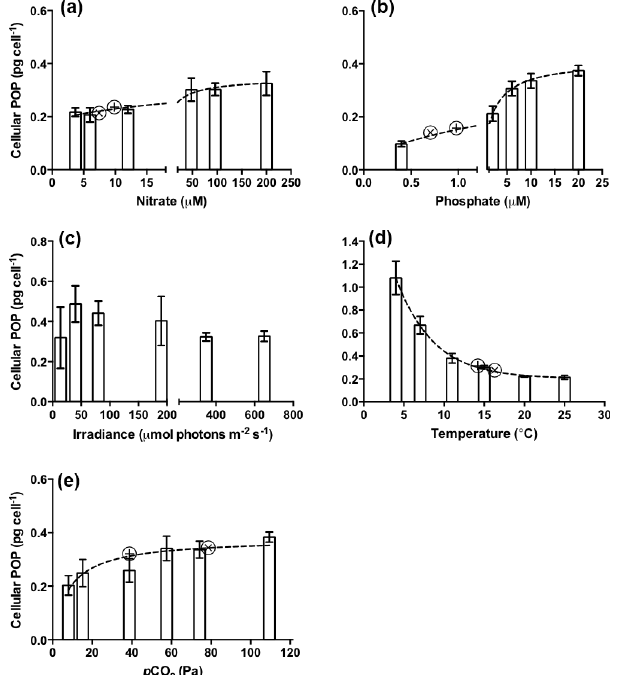
Figure 6. Changes in the ratio of Emiliania huxleyi cellular partic- ulate organic carbon content to chlorophyll a content (C:Chl a ) in response to different environmental drivers: (a) C:Chl a ratio vs. nitrate concentration, (b) C:Chl a ratio vs. phosphate concentra- tion, (c) C:Chl a ratio vs. irradiance, (d) C:Chl a ratio vs. temper- ature, and (e) C:Chl a ratio vs. p CO 2 . Error bars represent standard deviations ( n =